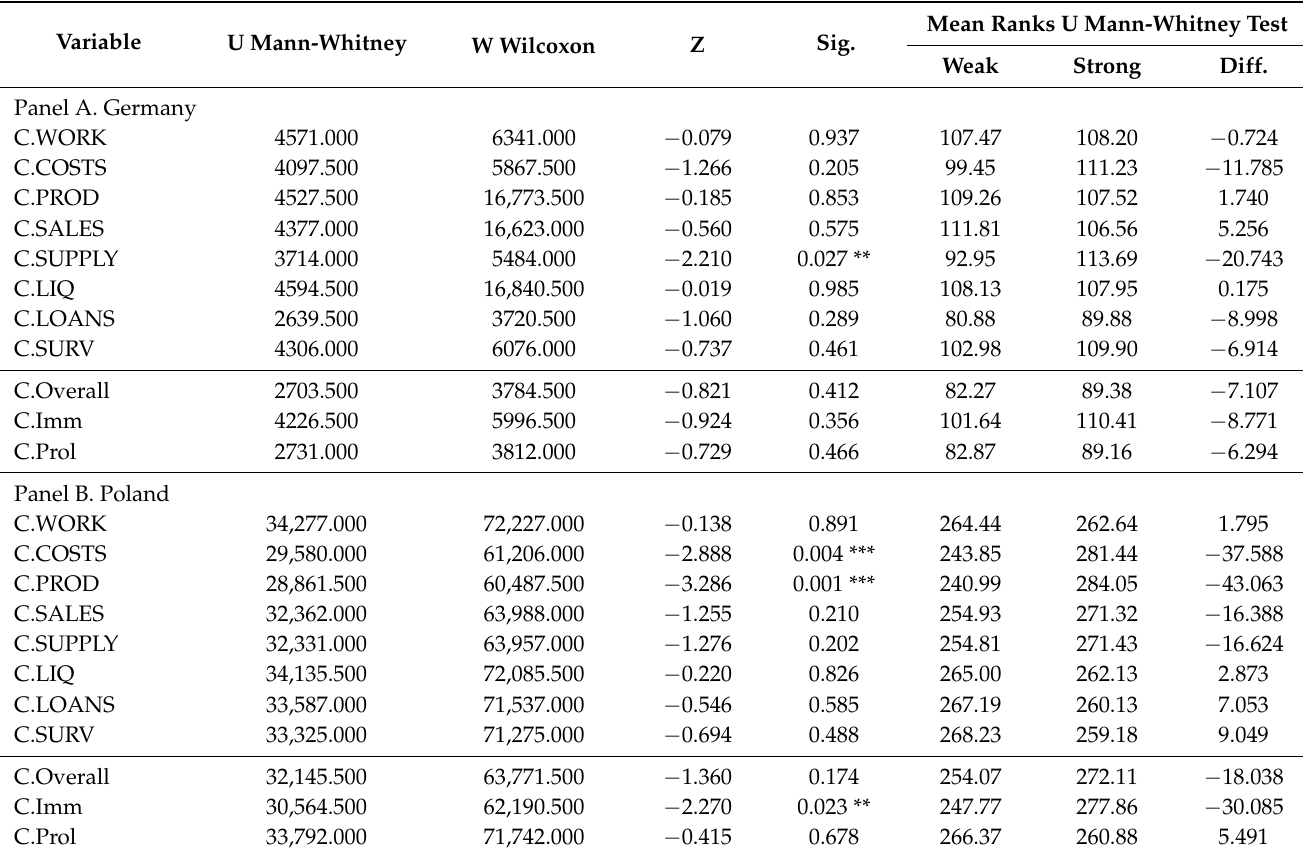
Table 10. Results of U Mann-Whitney test for the perceptions of COVID-19 impacts and the strength of CG mechanisms (group of weak vs. strong ERM